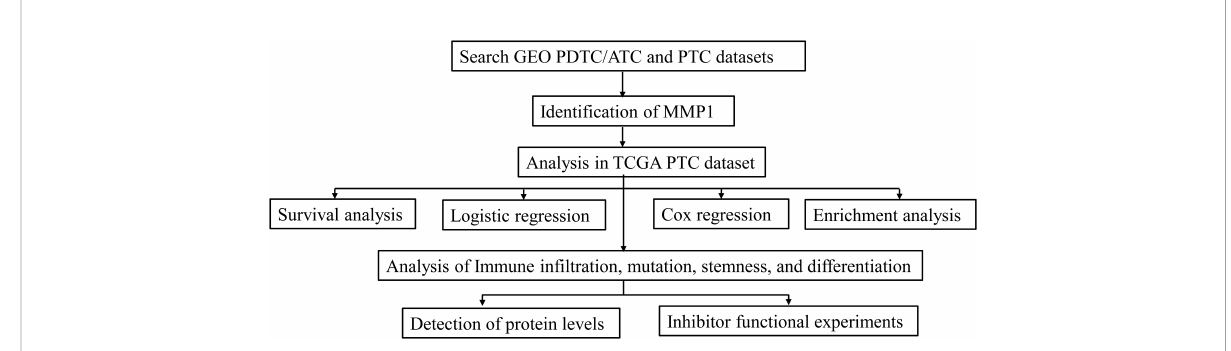
FIGURE 1 Flow diagram of this study. The details of data collection and analysis were exhibited in a fl ow diagram. GEO, the Gene Expression Omnibus; PDTC, poorly differentiated thyroid cancer; ATC, anaplastic thyroid cancer; PTC, papillary thyroid cancer; TCGA, The Cancer Genome